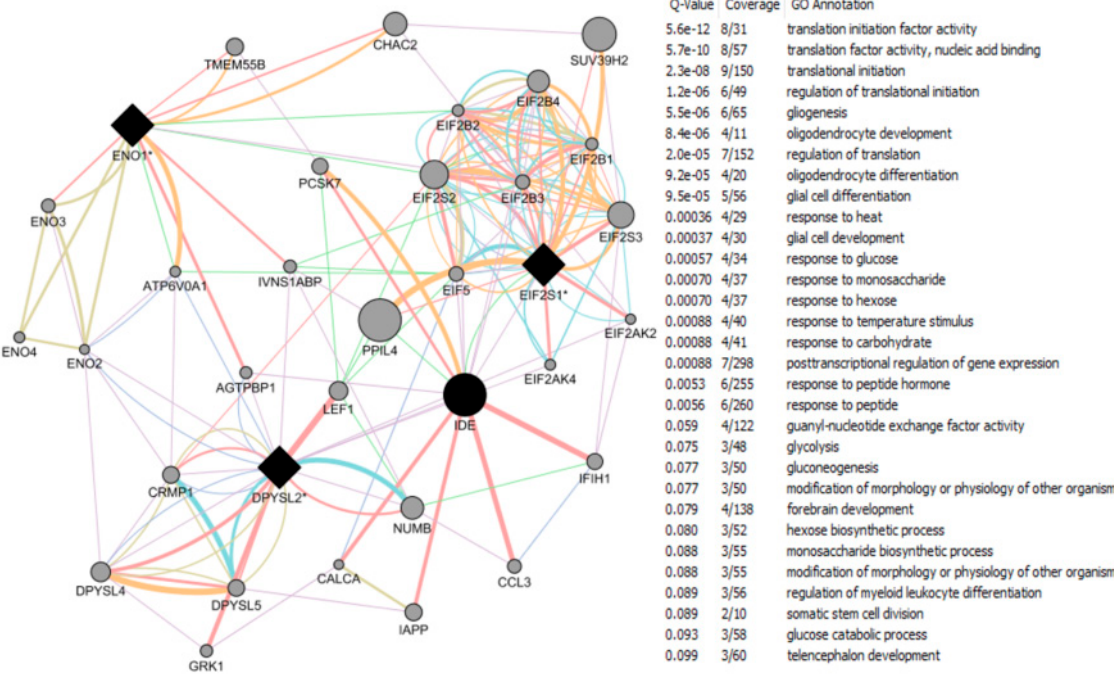
Figure 7. Gene set pathway enrichment analysis of dibutyl phthalate modified E2 and NRF1 common target genes associated with Alzheimer ′ s Disease (AD). The network includes the top 30 dibutyl phthalate related genes in AD in gray. Dibutyl phthalate responsive NRF1 genes are in black. Genes denoted by a diamond-shaped node and * are E2 and NRF1 responsive. Right panel show GO annotations of E2 and NRF1 enrichment network genes of dibutyl phthalate associated with biological process pathways involving multiple E2 and NRF1 genes and Q -value as a probability showing number of genes out of the total genes annotated to each GO term.